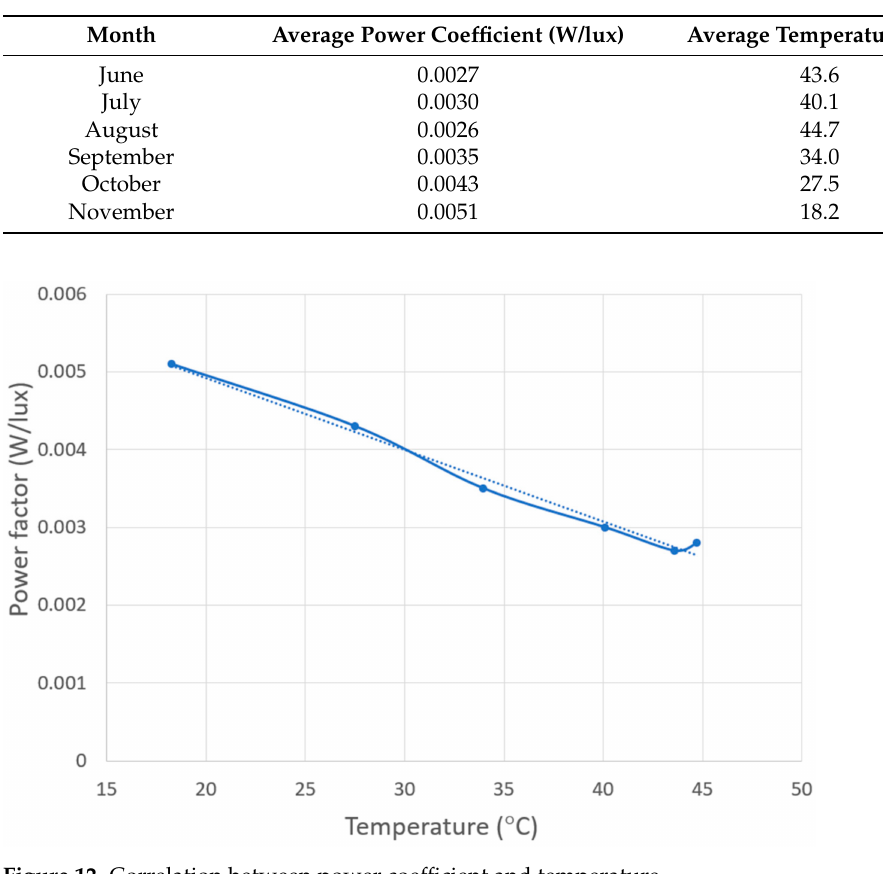
Figure 12. Correlation between power coefficient and temperature. Assuming temperature loss coefficient of 0.41%/ ◦ C above 25 ◦ C, the expected values of the power output can be adjusted in relation to the current intensity of solar radiation. Figure 13 shows the percentage distribution of power and intensity of solar radiation from the selected month (September 2019). The maximum recorded value is assumed as 100%.